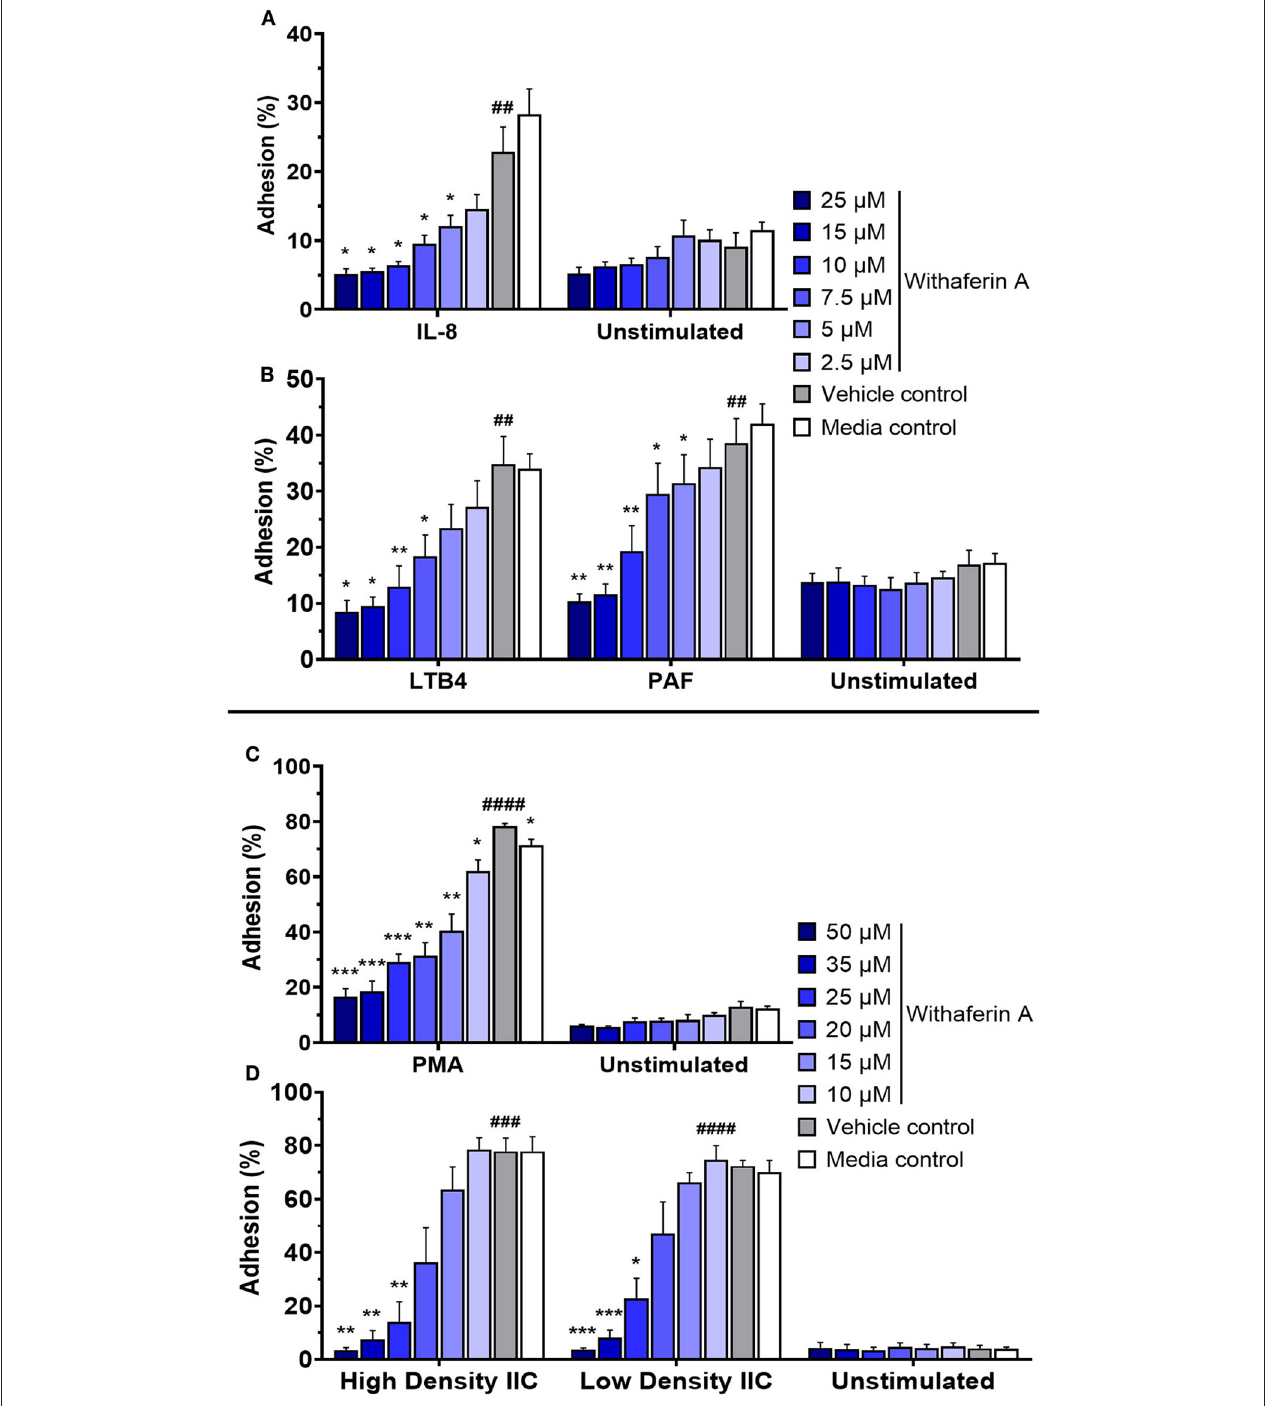
FIGURE 1 | Withaferin A inhibits neutrophil adhesion to substrate in response to PMA, insoluble immune complexes (IIC), IL-8, LTB4, and PAF. Mean (SEM) percent adhesion of treated equine neutrophils to 5% FBS-coated plastic with IL-8 [ (A) n = 4 horses], LTB4 [ (B) n = 5 horses], PAF [ (B) n = 5 horses], or PMA [ (C) n = 5 horses] stimulation or to IIC immobilized to plastic [ (D) n = 5 horses]. Fluorescent detection of calcein AM-loaded neutrophils after serial washes. One-tailed paired t-test of VC neutrophils; ## p < 0.01, ### p < 0.001, #### p < 0.0001 compared to unstimulated VC. One-way repeated measures ANOVA (Holm-Sidak multiple comparison testing); * p < 0.05, ** p < 0.01, *** p < 0.001, as compared to VC within same stimulation